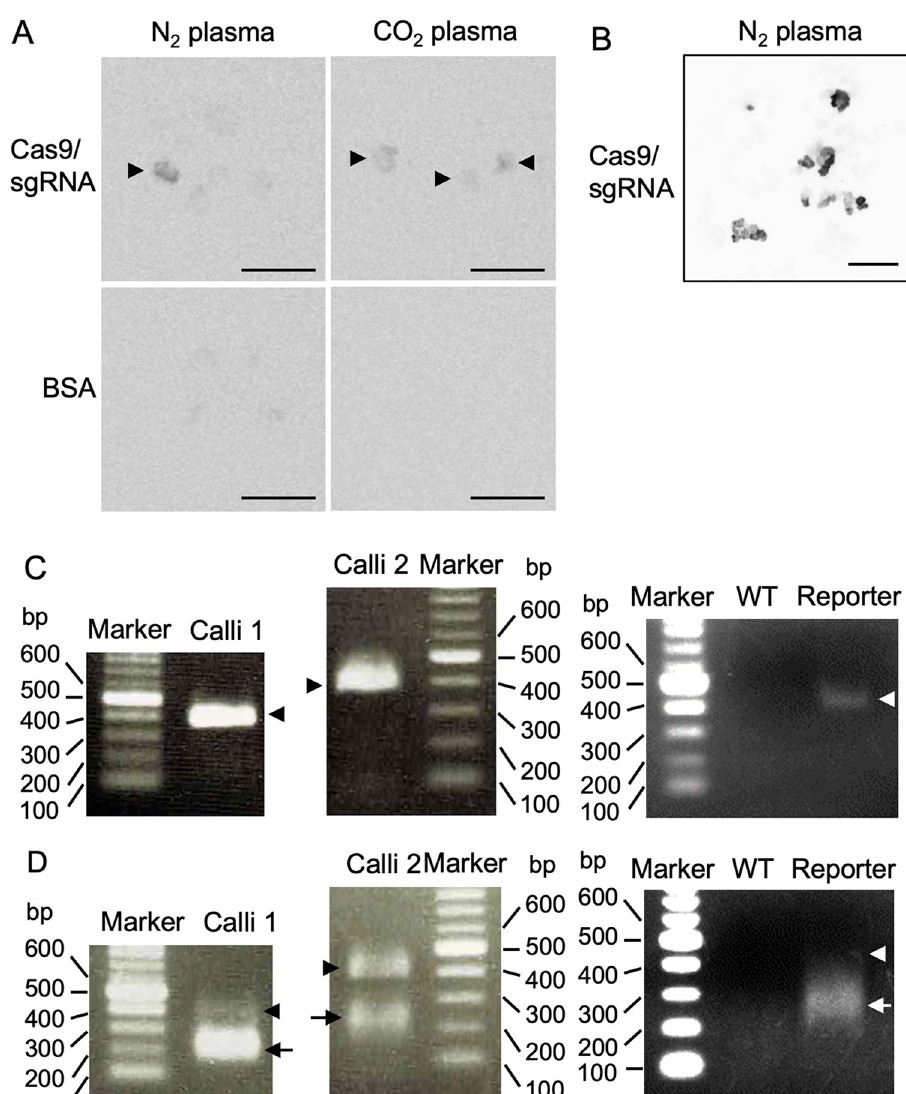
Fig 3. Detection of rice cells with edited genomes. (A) After calli introduced by Cas9/sgRNA or BSA were cultured on N6D medium for 5 days, they were treated with luciferin. Luminescence was detected in a part of calli introduced by Cas9/sgRNA but not BSA. Arrowheads indicate luminescent signals. Bars; 0.5 cm. (B) Luminescent calli were concentrated by culturing in a new medium and selection of luminescent calli every 2 weeks for 2 months. Bar; 1 cm. (C) Parts of CaMV 35S promoter and LUC ORF comprising the I- Sce I recognition sequence were amplified via PCR from genome DNA extracted from the independent luminescent calli (Calli 1 and Calli 2), untreated calli with (Reporter) and without (WT) the L-(I-SceI)-UC reporter gene. The amplified fragments were observed by agarose gel electrophoresis. Note that no detectable band was obtained in wild type (WT), indicating that the fragment was amplified from the reporter gene. Arrowheads indicate the PCR fragments. (D) The amplified samples were digested by I- Sce I. Genome editing by Cas9/sgRNA produces I- Sce 1 resistant fragment. The digested samples were separated by agarose gel electrophoresis. I- Sce I digested bands are shown by arrows. Arrowheads indicate fragments that could not be cut by I- Sce I. Fig 3D. The sequencing data are shown in Fig 4. A sequence with the deletion of 3 base pairs (CGA) and insertion of 2 base pairs (AA) was identified and designated as edited genome 1, which was observed in 7 plasmid DNA sequences out of the 10 plasmids isolated from calli 1